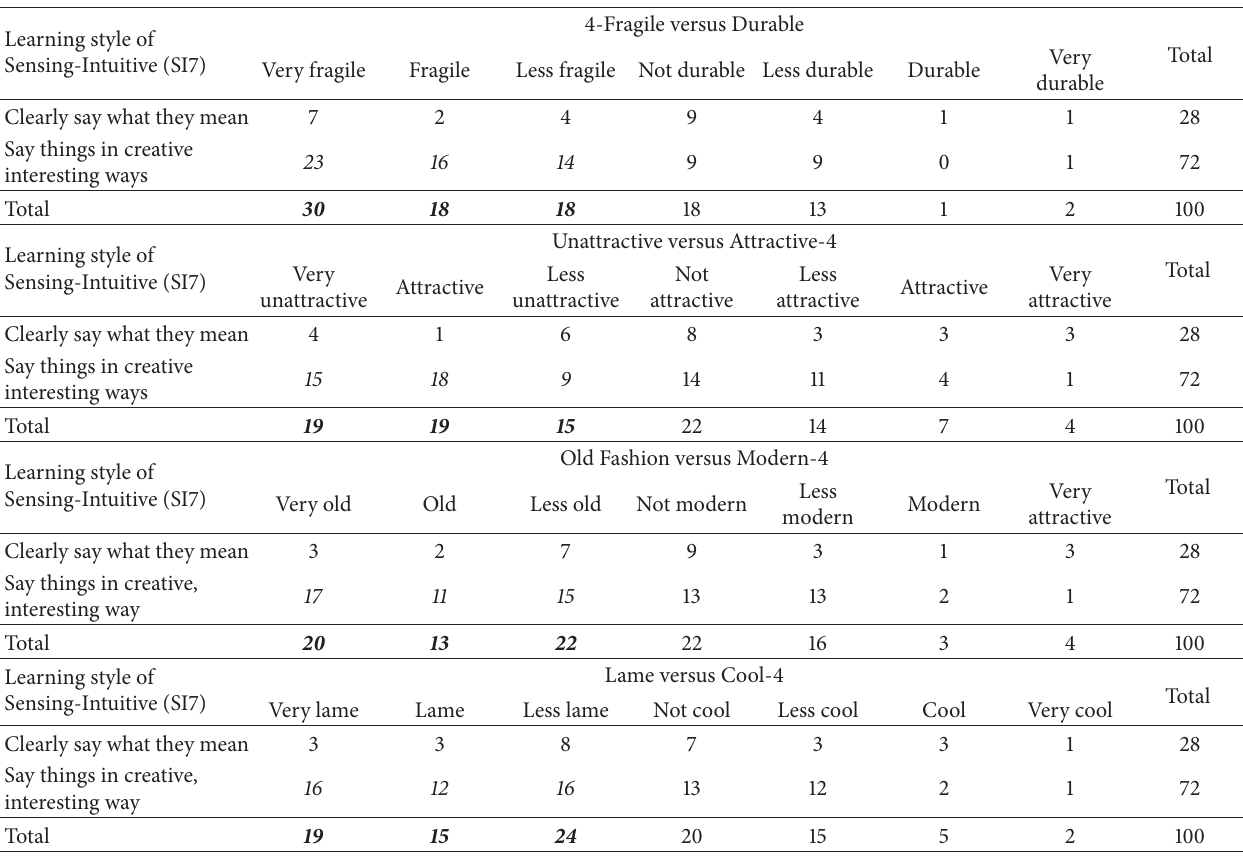
Table 20: The Interpretation of Design no. 4 versus the students preferences in enjoyment of reading the book (SI7) (Based on Kansei words of fragile—durable, unattractive—attractive, old fashion—modern,